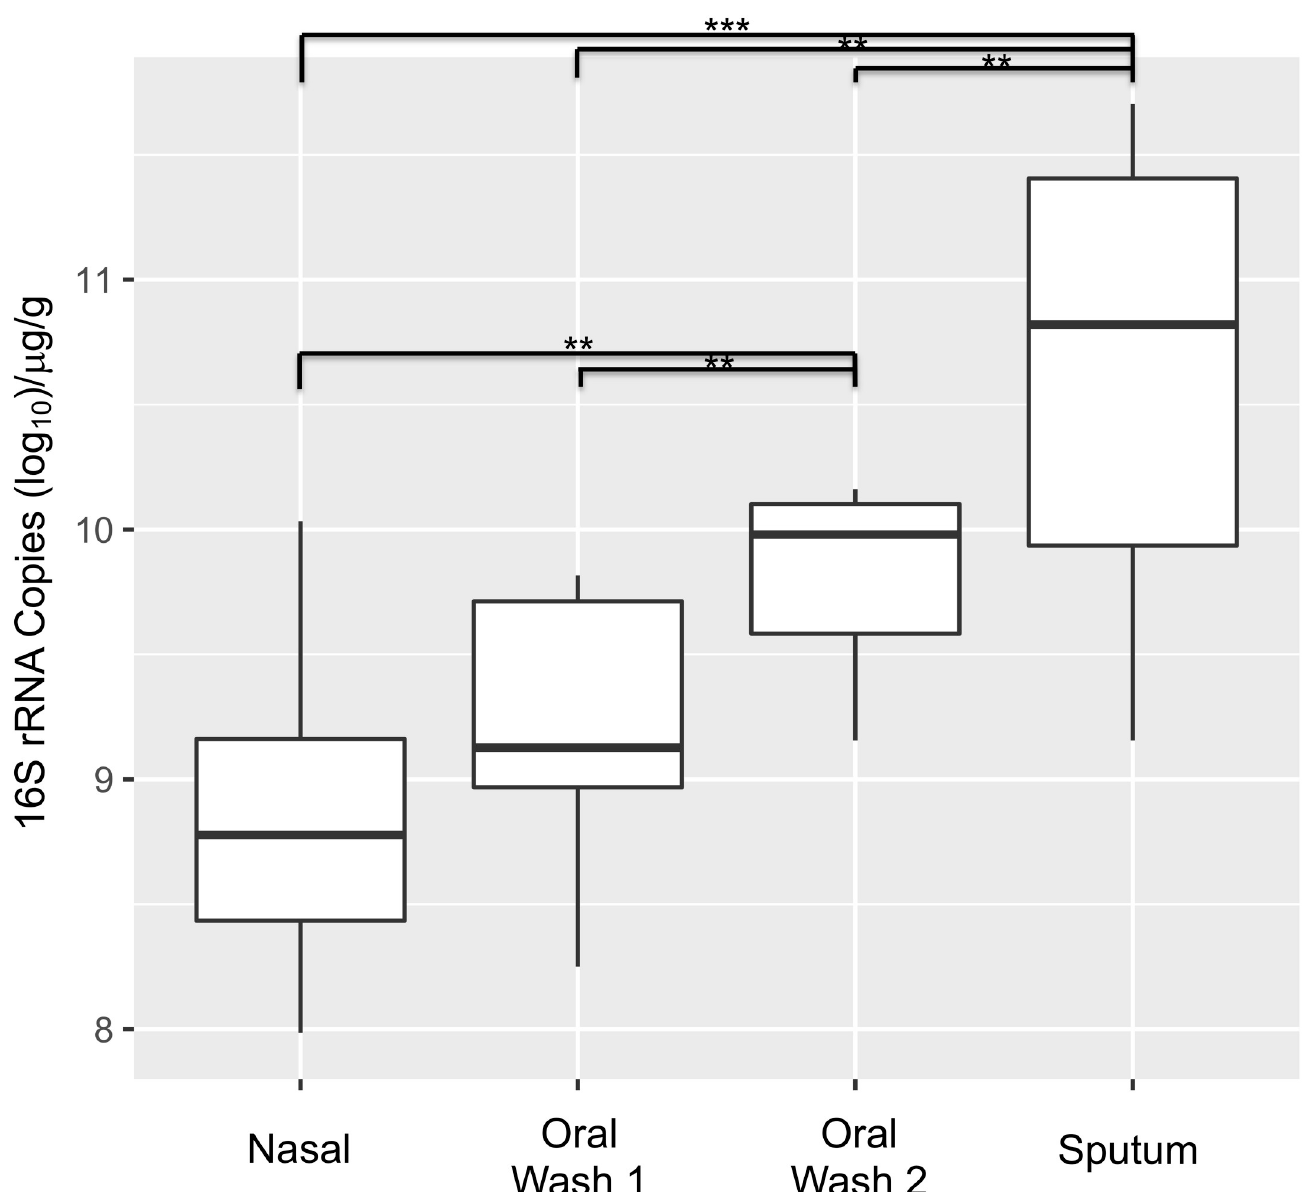
Fig 2. 16S rRNA copy number is associated with site. A generalized estimating equation model with an exchangeable correlation structure was used with anatomic site as a predictor and patient as a random effect. Anatomic site was a significant predictor of 16S copy numbers ( p < 0.001). Follow-up pairwise t -tests revealed that all pairwise comparisons were significant with the exception of the nasal-oral wash 1 comparison ( p = 0.08). Inclusion of smoking status, edentulous state, age, and FEV1pp in the model (in addition to anatomic site) resulted in non-significant p -values for the above-mentioned clinical factors. ( ��� p < 0.0001; �� p =